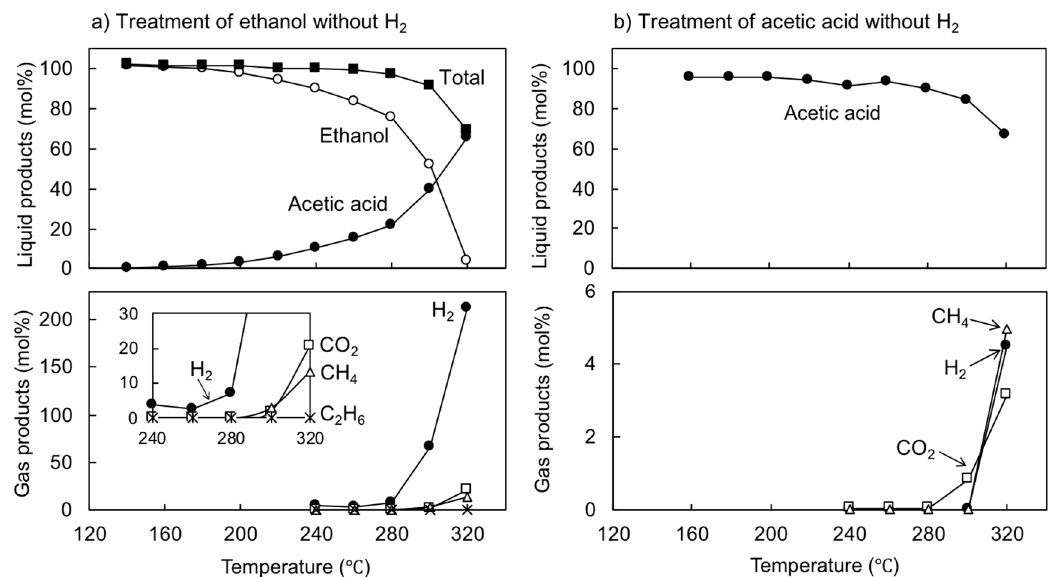
Figure 4. Product yields from treatment of aqueous ( a ) ethanol and ( b ) acetic acid (10 g/L each) without H 2 (column size, 3.9-mm inner diameter, 100-mm length; pump flow rate, 0.3 mL/min; pressure, 10